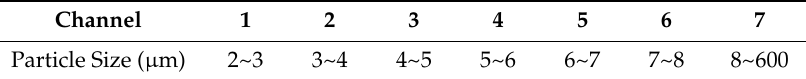
Table 1. Output data channels of the particle counter.